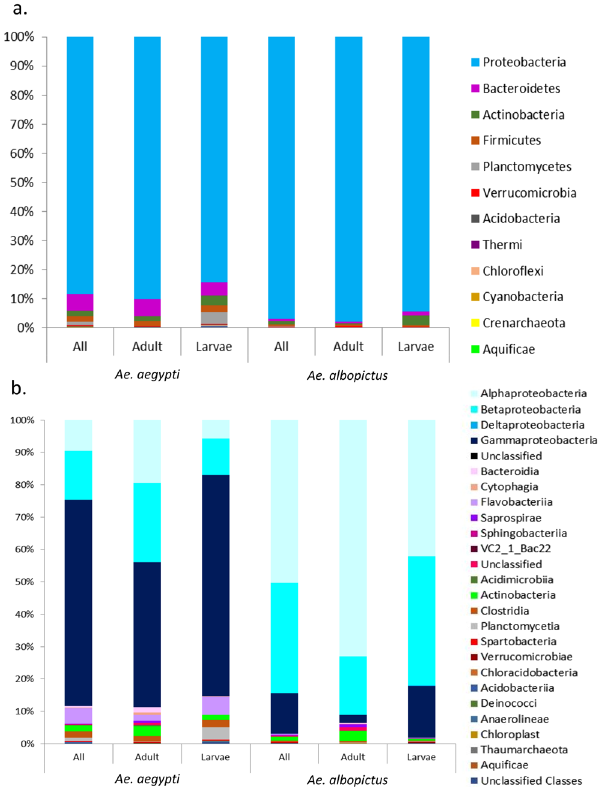
Figure 3. Bar plot of the relative abundances of ( a ) the bacterial phyla and ( b ) the bacterial classes within Ae . aegypti and Ae . albopictus summarized across all samples and compared to the bacterial profiles of the adults and larvae for each